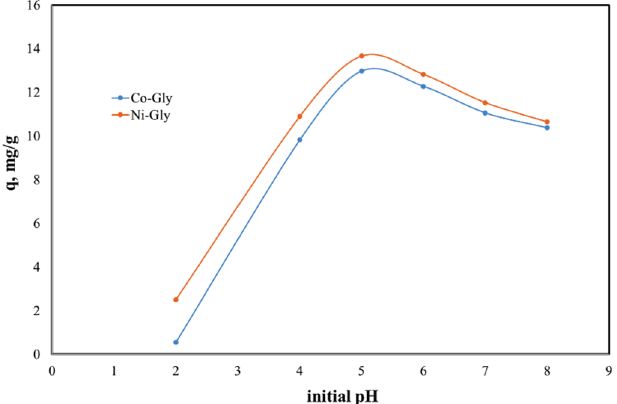
Figure 3. pH effect upon the adsorption capacity of the studied materials in the removal process of Cd(II) ions from aqueous solutions.